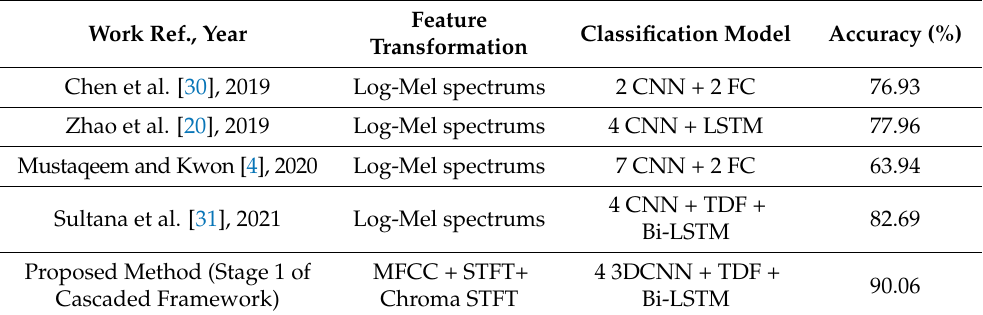
Table 6. Performance (i.e., test set Accuracy) comparison with State-of-the-arts on emotion recognition. Work Ref., Year